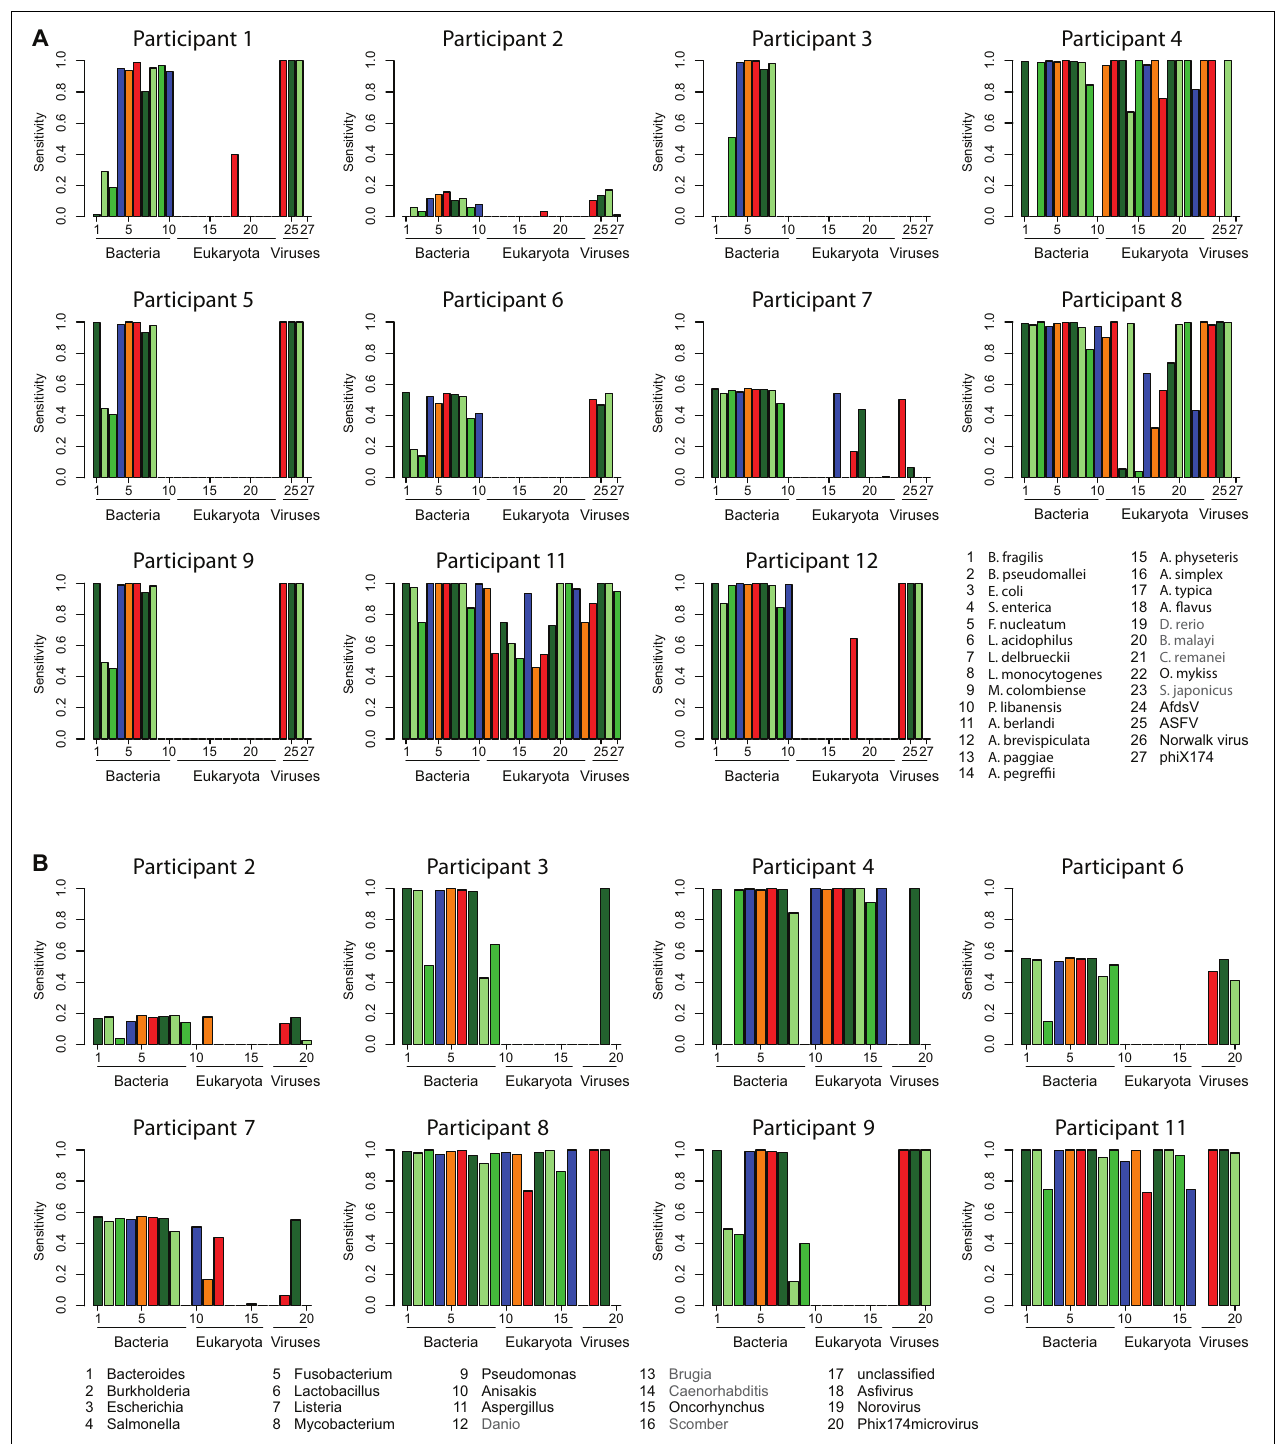
FIGURE 3 | Sensitivity of read assignments calculated from the complete read set. (A) Sensitivities calculated based on the species assignments. (B) Sensitivities calculated based on the genus assignments. Sequences of the taxa labeled gray ( Brugia malayi , Caenorhabditis remanei , Danio rerio , and Scomber japonicus ) were downloaded unintentionally as part of the Anisakis sequence